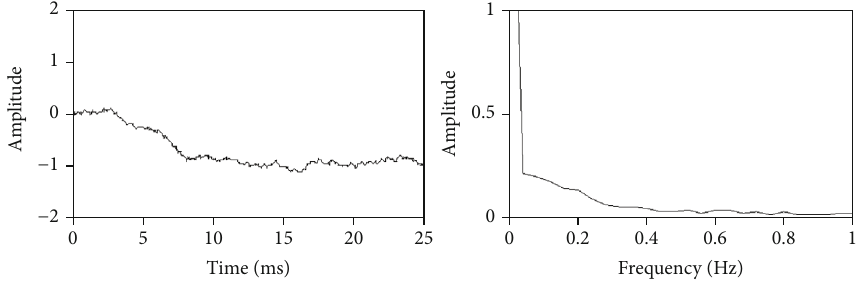
Figure 7: The time and frequency spectrum of the system input and output when a = 11 and b = 0 : 8